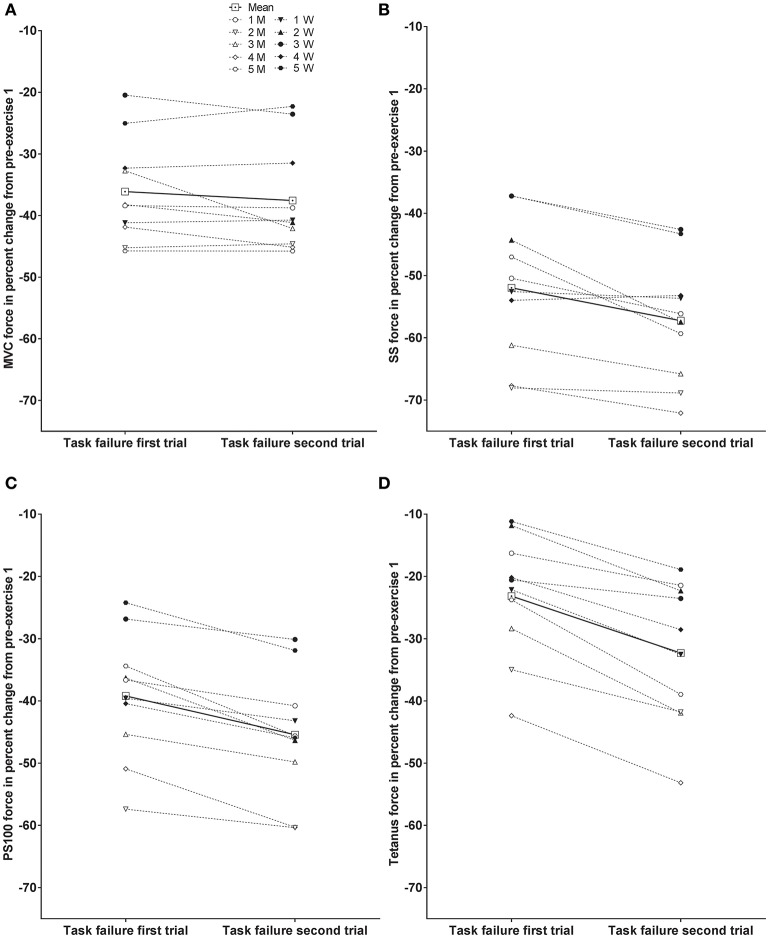
Individual responses at task failure of the first and second trial as percent change from pre-exercise prior to the first trial; maximal voluntary contraction (MVC) force (A), evoked peak force for single stimulus (SS) (B), evoked peak force for paired stimuli at 100 Hz (PS100) (C), and evoked peak force for 50 stimuli at 100 Hz (tetanus) (D). Male subjects (M) are indicated with open symbols, and female subjects (W) are indicated with closed symbols. Significant differences are presented in Table 1.